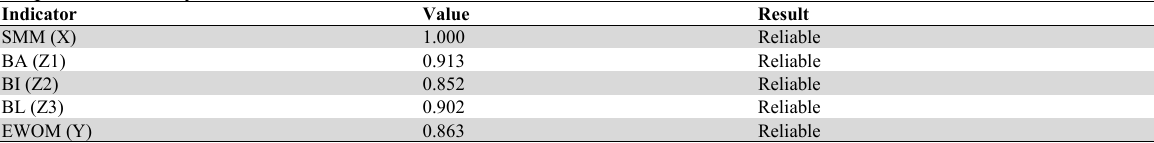
Composite Reliability